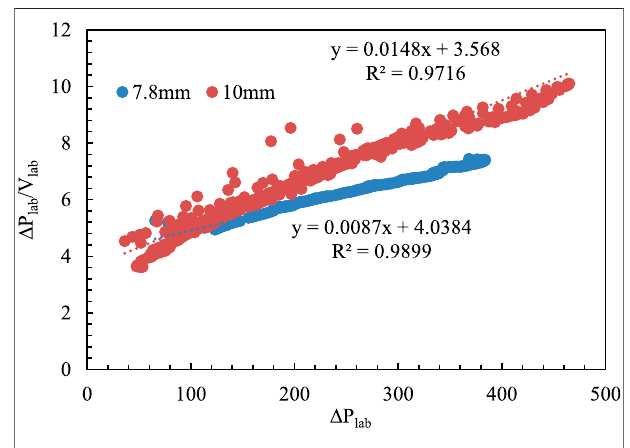
FIGURE 6 | Relationship between Δ P lab /V lab and Δ P lab .